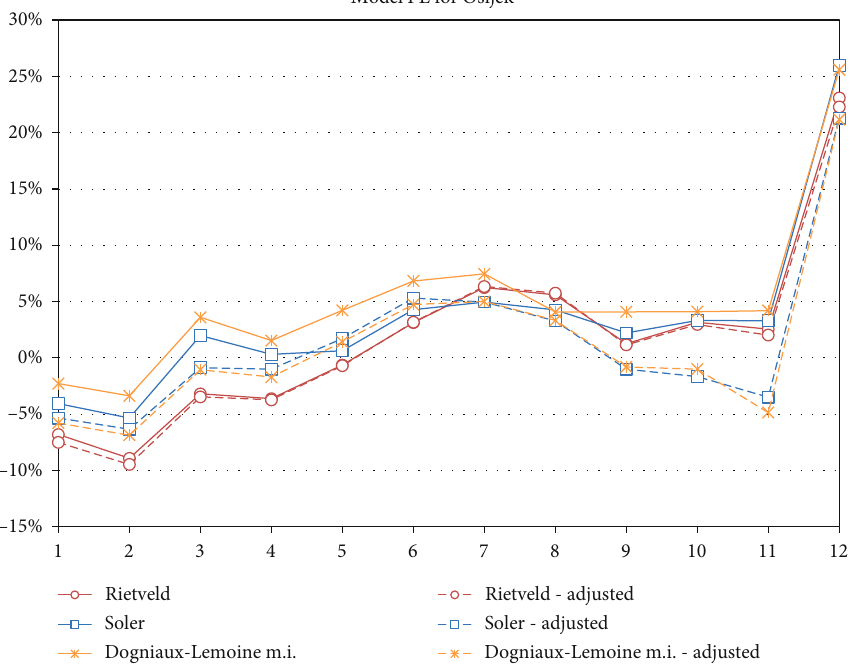
Figure 3: Comparison of percentage error of original and adjusted models for Osijek.